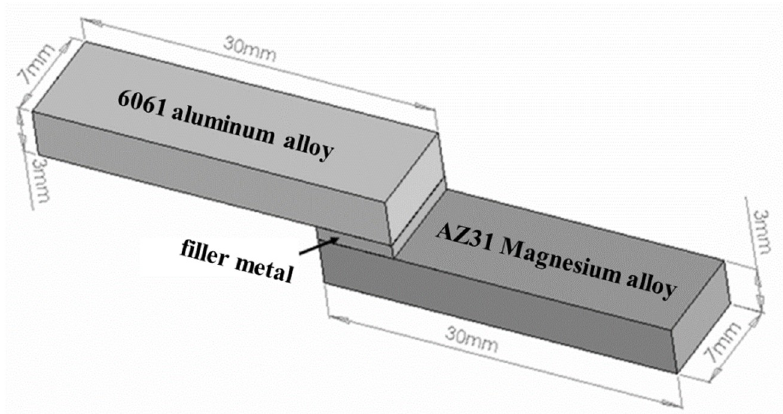
Figure 1. Schematic representation of the soldered specimens used for shear testing in this study.